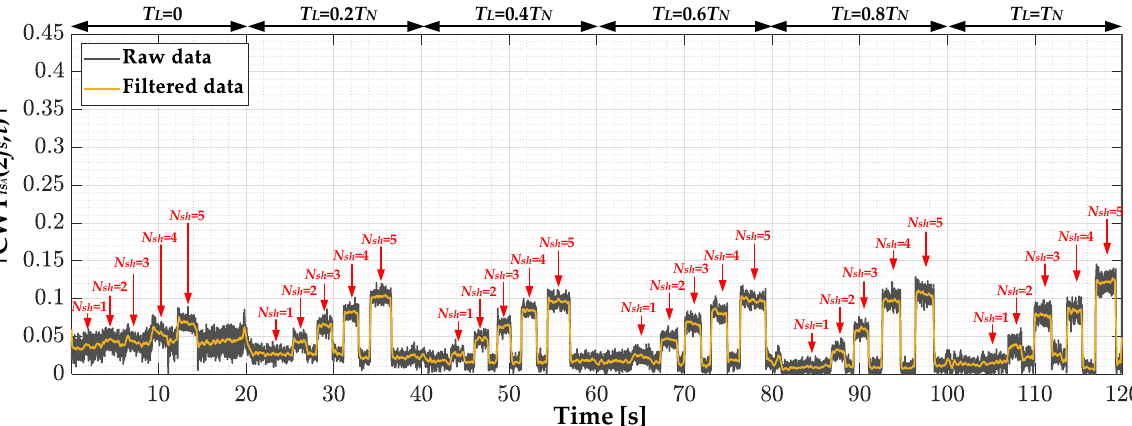
Figure 9. The raw and filtered waveforms of the |CWT isH A (2 f s , t )| value during the cyclic momentary short-circuiting of 1 to 5 turns and different load torques levels ( T L = var, f s = f sN = 100 Hz). In Figure 10, the 2D and 3D CWT scalograms of the stator phase current space vector module signal are presented. In this case, as for stator phase current envelope CWT analysis, the increase in the value of the coefficient related to the second harmonic, the 2 f s component |CWT |is| (2 f s , t )|, is visible. Figure 11 shows the raw and filtered